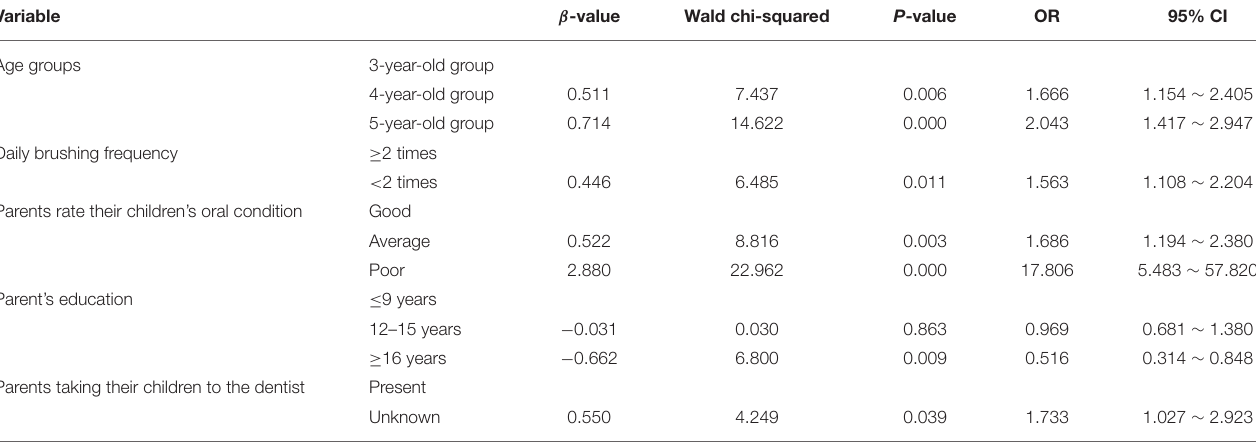
TABLE 3 | Logistics regression analysis of 1,291 children aged 3–5 years in Guizhou Province.